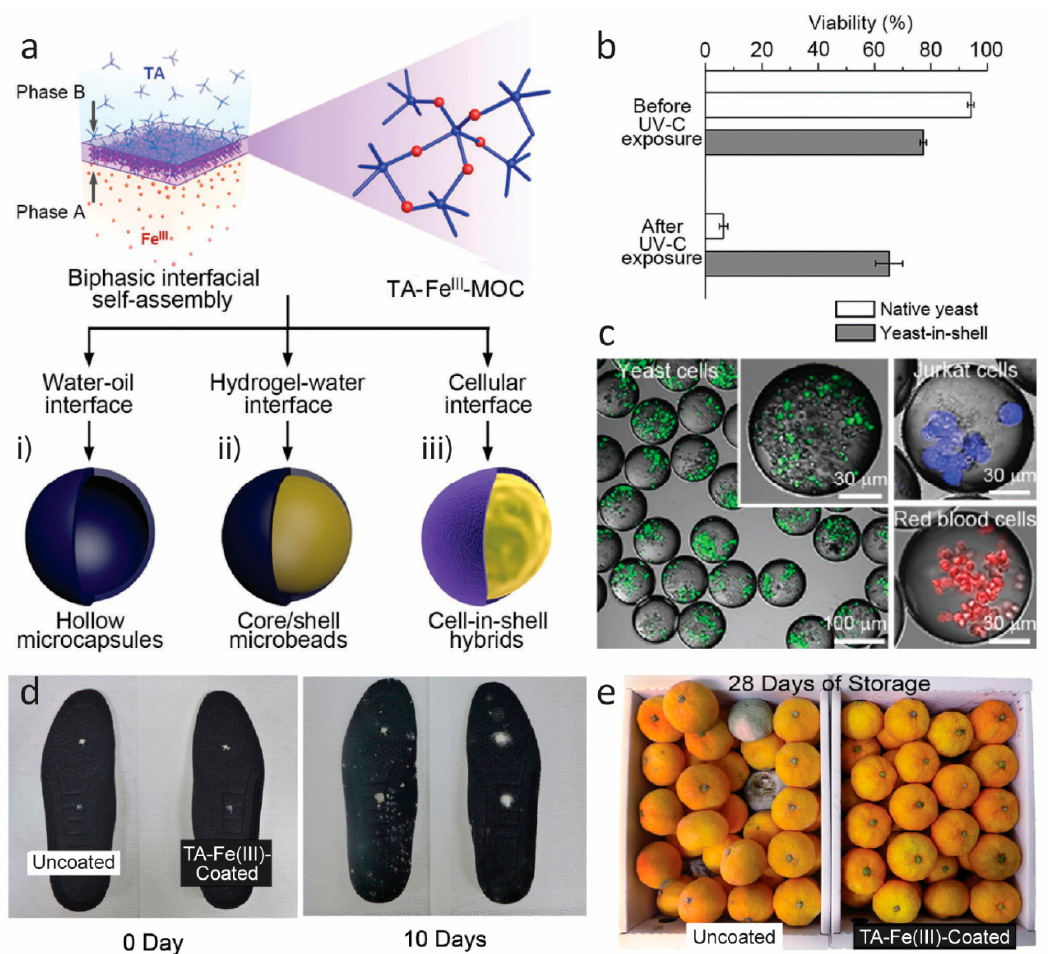
Figure 7. ( a ) Schematic representation of interfacial supramolecular self-assembly of Fe(III) and tannic acid (TA) at various interfaces. Fe(III) ions are preloaded into one phase (phase A), and the supramolecular self-assembly is induced at the interface of two immiscible phases by TA in the other phase (phase B). ( b ) Cytoprotective capability of yeast-in-shell hybrids (obtained from path ( a ,iii)) from ultraviolet (UV)-C irradiation. After fluorescein diacetate treatment, the cells in green were considered alive. All data are shown as the mean ± standard deviation ( n = 3). ( c ) Confocal laser scanning microscopy images of the microcapsules (obtained from path ( a ,i)) that encapsulate yeast cells (green), Jurkat cells (blue), or red blood cells (red). The cells were labeled with CellTracker TM green CMFDA (5-chloromethylfluorescein diacetate) dye (for yeast cells), CellTracker TM violet BMQC dye (for Jurkat cells), and CellTracker TM deep red dye (for red blood cells). ( a – c ) Reproduced with permission from [100]. Copyright 2017 WILEY-VCH Verlag GmbH & Co. KGaA, Weinheim. ( d ) Optical photographs of uncoated and TA–Fe(III)-coated shoe insoles after inoculation of Trichophyton rubrum (white) and ( e ) mandarin oranges ( Citrus reticulata ) after storage at room temperature.